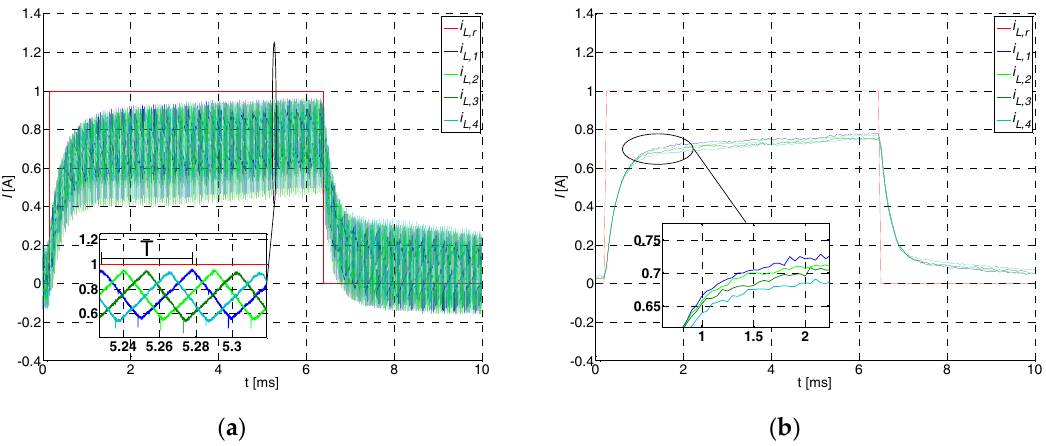
Figure 7. Phase currents’ i L ,1 ... 4 responses to step change of current reference i L , r from 0 to 1 A when SMC is used, based on a nominal model without uncertainties; ( a ) real current values and ( b ) current values, sampled by digital signal processor (DSP).